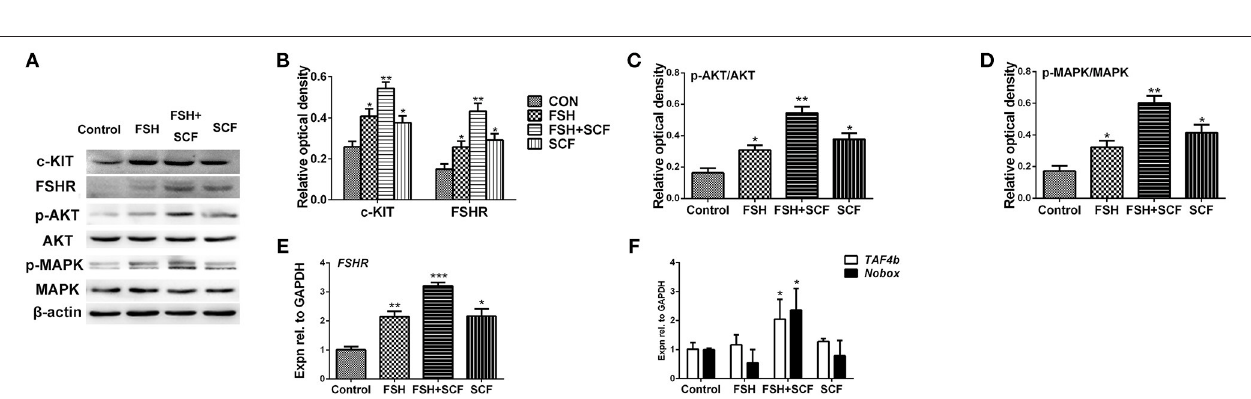
FIGURE 6 | SCF enhanced the stimulatory effect of FSH in vitro . The 4-day-old chicken ovaries were treated with FSH and SCF for 2 days in culture. (A,B) Western blot and gray analysis indicate that SCF enhanced the effect of FSH on promoting c-KIT and FSHR protein expressions. (E) qRT-PCR analysis indicates that SCF could enhance the effect of FSH to promote FSHR mRNA expression. Western blot and gray analysis indicate that SCF could enhance the effect of FSH to increase ratio of p-AKT/AKT (A,C) and ratio of p-MAPK/MAPK (A,D) . (F) FSH also combined with SCF to promote TAF4b and Nobox mRNA expression. T -tests were used to determine statistically significant differences. The values are the mean ± SEM of six experiments. Asterisks indicate significant differences (* P < 0.05, ** P < 0.01, *** P <